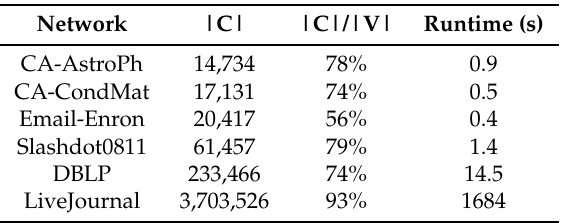
Table 2. Results for real-life social